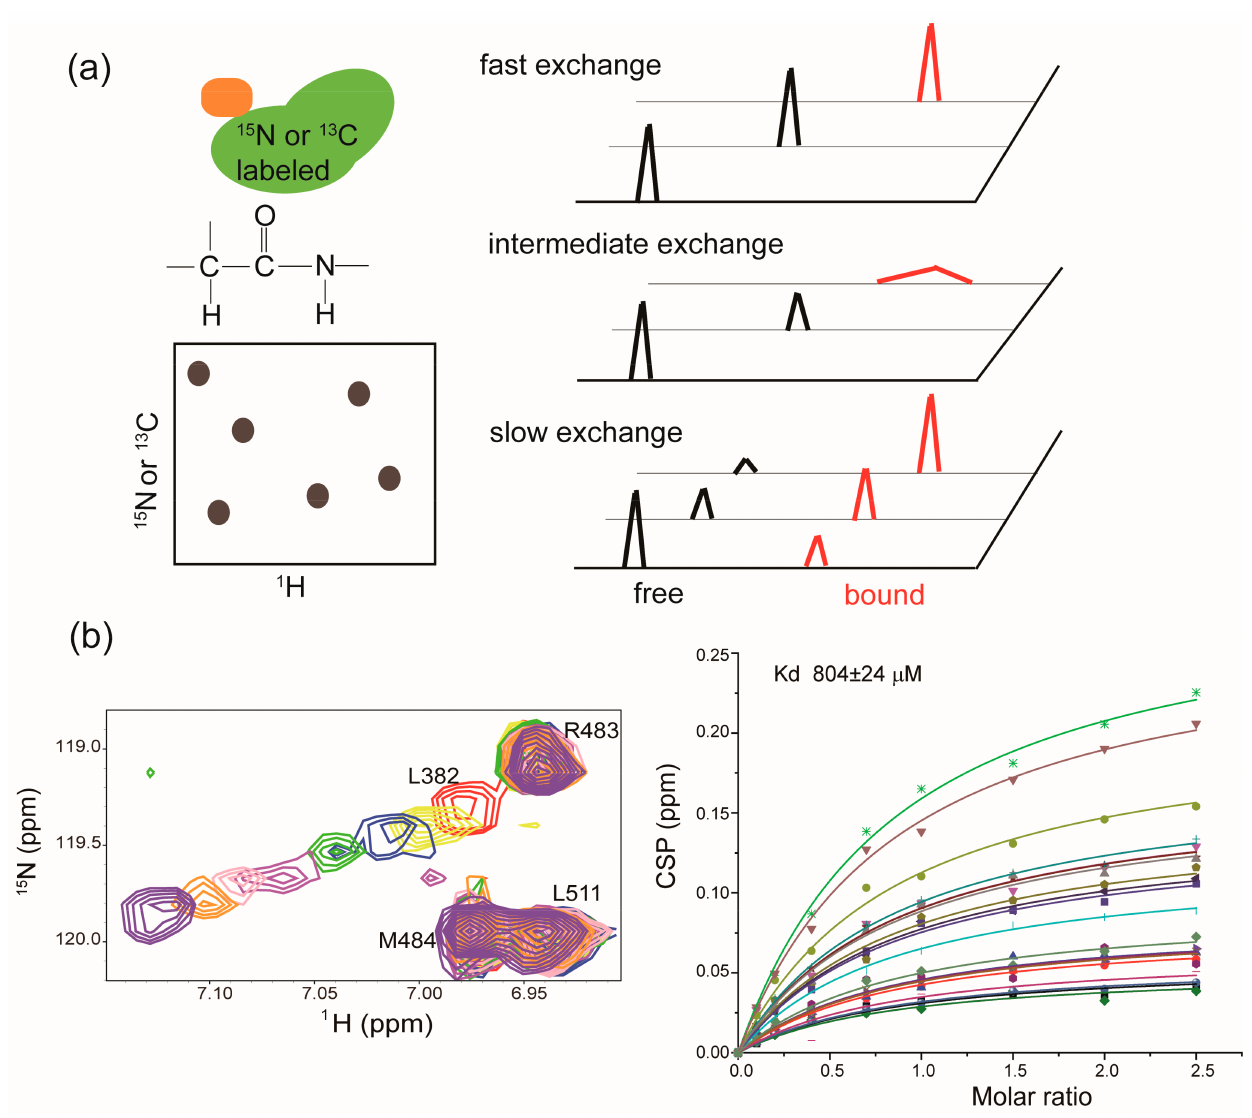
Figure 3. Target-observed NMR in hit compound screening and/or validation: ( a ) Cartoon illustration of the HSQC/HMQC experiments, and each contour in the spectrum serves as a residue-specific fingerprint. The right panel shows the NMR behavior of perturbed residues in target protein upon the addition of weak binder, moderate binder and strong binder, respectively. ( b ) Zoomed view of the superposition of [ 1 H, 15 N] HSQC spectra of Hsp90M upon the titration of SOMCL-16- 175. The spectra are colored according to the molar ratio of Hsp90M to SOMCL-16-175 applied in spectrum acquisition: 1:0 (red), 1:1 (yellow), 1:2 (blue), 1:4 (green), 1:7 (magenta), 1:10 (pink), 1:15 (orange), 1:25 (purple). The dissociation constant for the binding of SOMCL-16-175 to Hsp90M was determined by the global fitting analysis of CSP